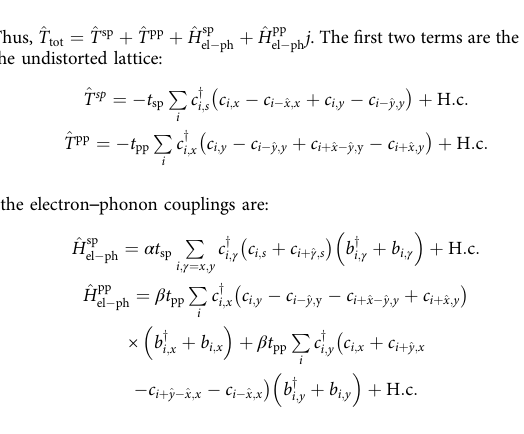
Fig. 4 Free hole dispersion (color online). Free hole dispersion E ( k ) for t sp = − 1, ϵ = ϵ = 0 and a t = − 0.4, b t = − 0.6. The ^ σ xy eigenvalue is indicated pp pp s p along the cut Γ = (0, 0) ↔ M = ( π , π ). For b only the lower two bands which cross in a type II Dirac point are